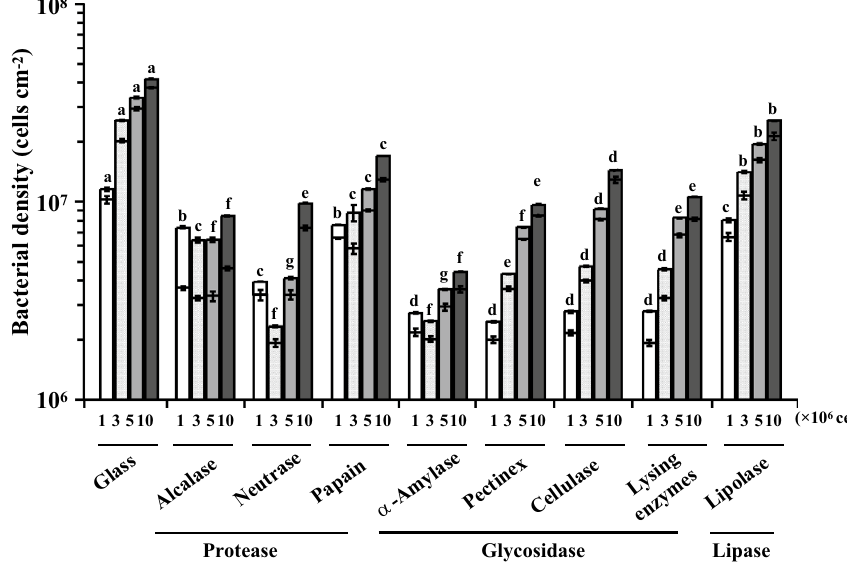
Figure 2. Bacterial density in S. marisflavi biofilm with different enzyme treatments.